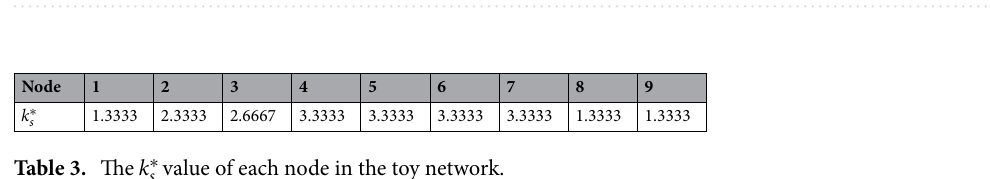
Table 2. The process of k -shell decomposition in the toy network.